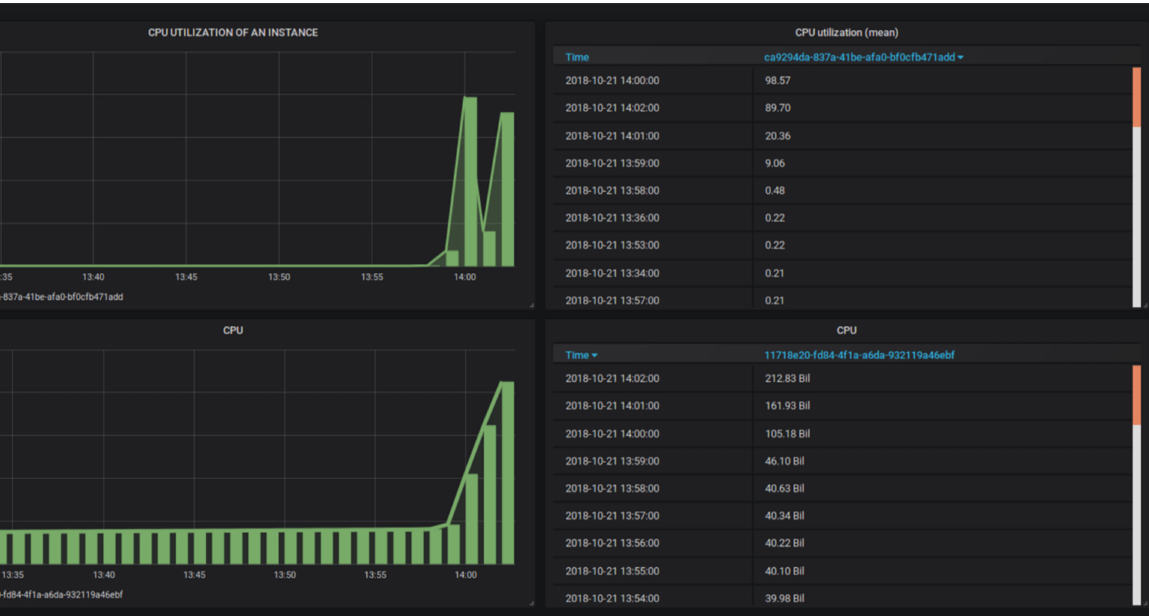
Figure 15. CPU utilization of VNF, Scale-out, and Scale-in.